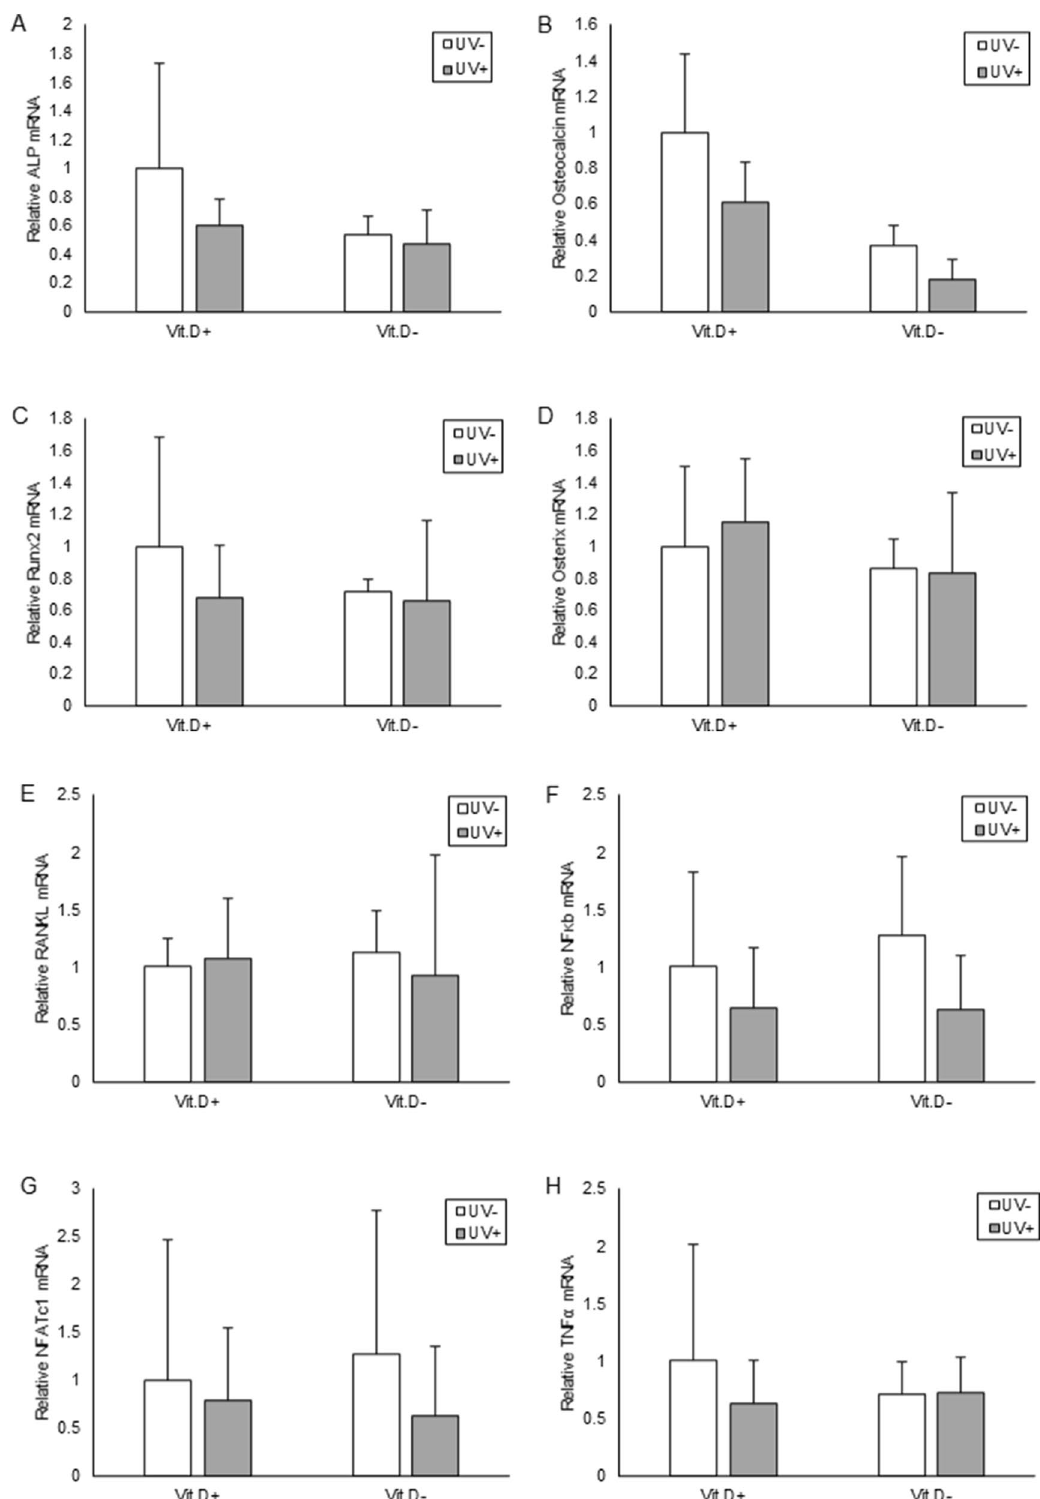
Figure 10. Expression levels of mRNA correlated with bone metabolism. Relative expression levels of target mRNA are graphed with reference to that in Vit.D+ UV− group as defined 1.0. Expression levels of target mRNA were normalized with those of Gapdh mRNA. ( A ) Relative ALP mRNAs. ( B ) Relative Osteocalcin mRNAs. ( C ) Relative Runx2 mRNAs. ( D ) Relative expression levels of Osterix mRNAs. ( E ) Relative RANKL mRNAs. ( F ) Relative expression levels of NFκb mRNAs. ( G ) Relative expression levels of NFATc1 mRNAs. ( H ) Relative expression levels of TNFα mRNAs. * p < 0.05. Vit.D − vitamin D-deficient diet; Vit.D + vitamin D-replete diet; UV ultraviolet irradiation; ALP alkaline phosphatase; Runx2 Runt-related transcription factor 2; RANKL receptor activator of NFκB ligand; NFκB nuclear factor kappa B; NFATc1 nuclear factor of activated T